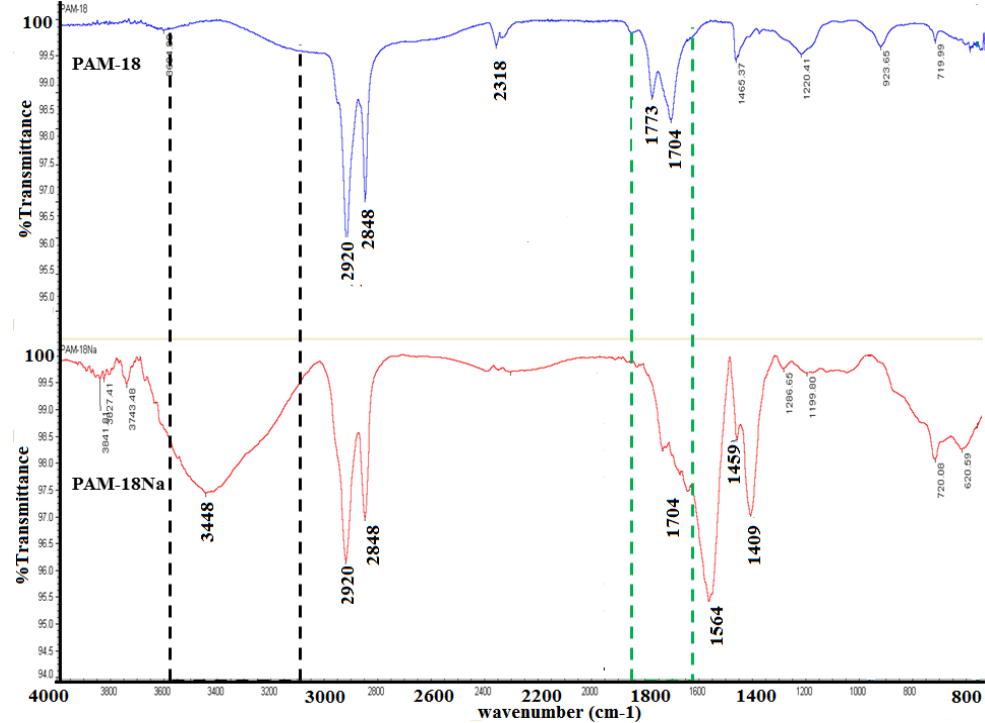
Figure 2. FTIR of PAM-18Na and PAM-18 polymer materials.